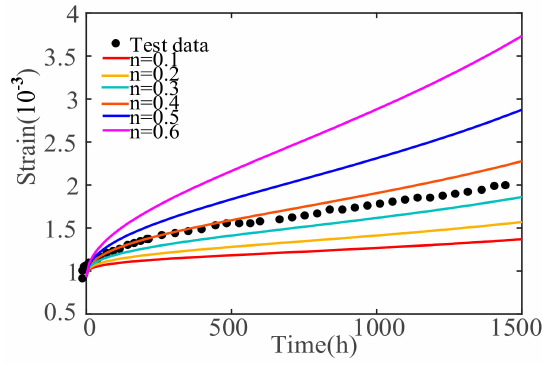
Figure 8. Sensitivity analysis under di ff erent orders of n.